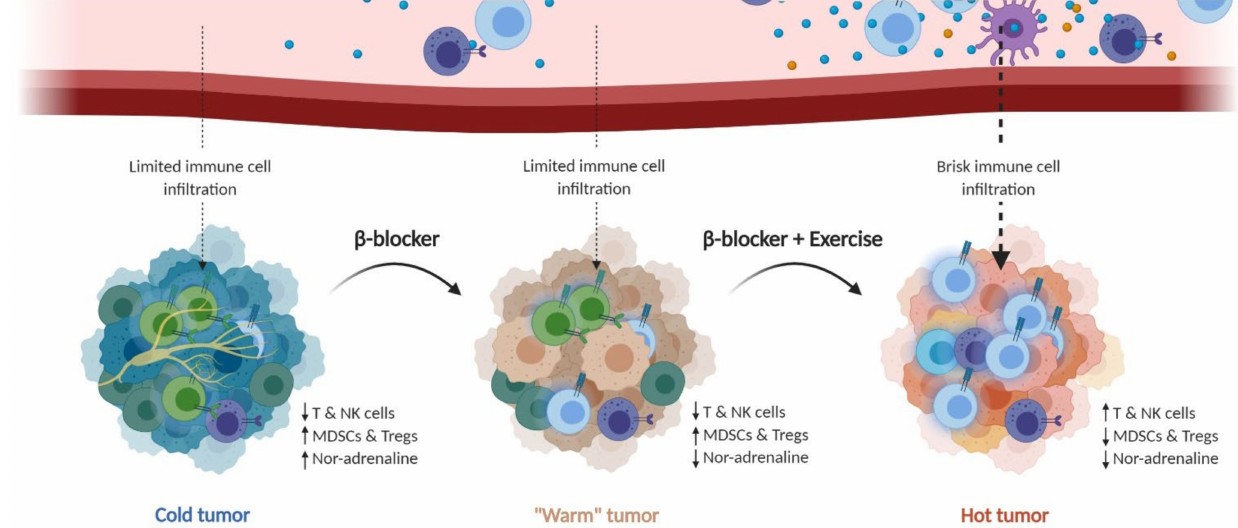
Figure 2. β -blockers and exercise: can they be combined/work together? Adrenergic signaling is a double-targetable checkpoint in immunotherapy of cancer. Adrenergic signaling seems to be dependent on multiple factors, such as acute and chronic stimuli. Based on mice studies, there is evidence to suggest a therapeutic benefit from both blocking chronic adrenergic signaling by β -blockers, as well as using the advantages of acute adrenergic signaling by exercise. We therefore hypothesize that adrenergic signaling can be a double-targetable checkpoint pathway, with one target being chronic noradrenaline stimulation of β -adrenergic receptors in the tumor microenvironment by administering β -blockers, which may turn a cold tumor to a “warm” tumor. The other target utilizes the positive effect of acute adrenergic signaling by exercise, leading to exercise-induced mobilization and tumor infiltration of cytotoxic lymphocytes (T and NK cells), thus turning the “warm” tumor into a hot tumor. Simultaneously β -blockers and exercise could be used as combinatorial “sequence” treatments, together with the respective immunotherapy cancer treatment. NK cells; natural killer cells. MDSCs; myeloid-derived suppressor cells. Tregs; regulatory T